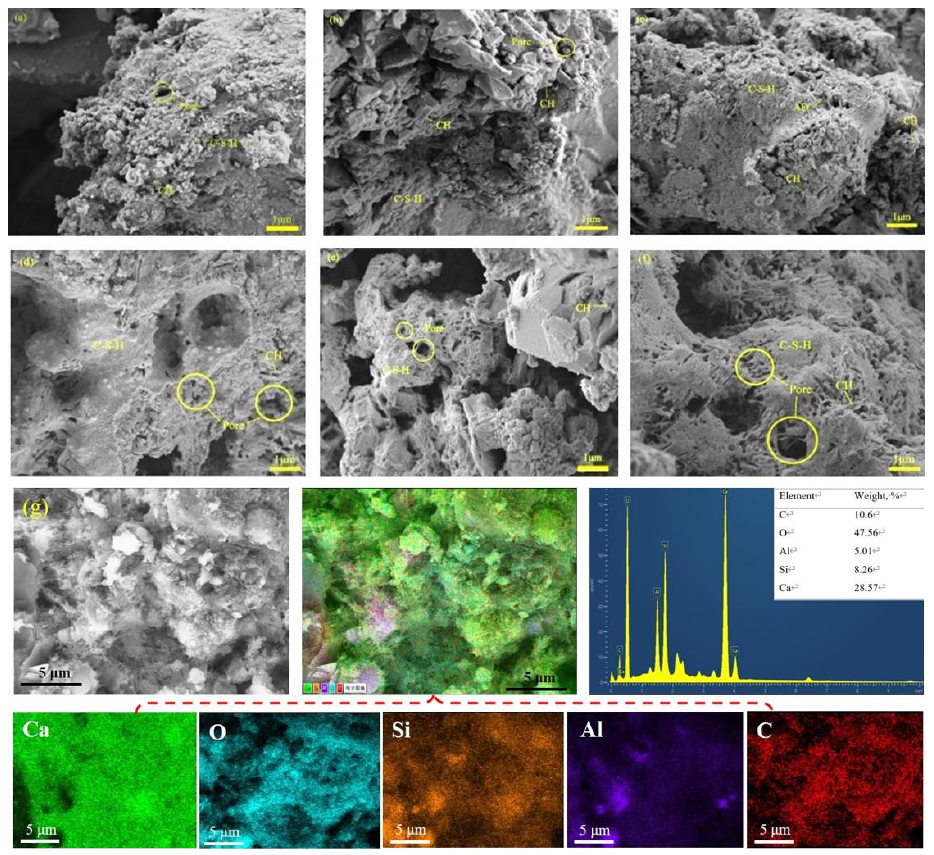
Figure 2. SEM images of various cement specimens, ( a ) PC0; ( b ) PC0.2; ( c ) PC0.4; ( d ) PC0.6; ( e ) PC0.8; ( f ) PC1.0; and ( g ) EDS elemental mapping of PC0.6.